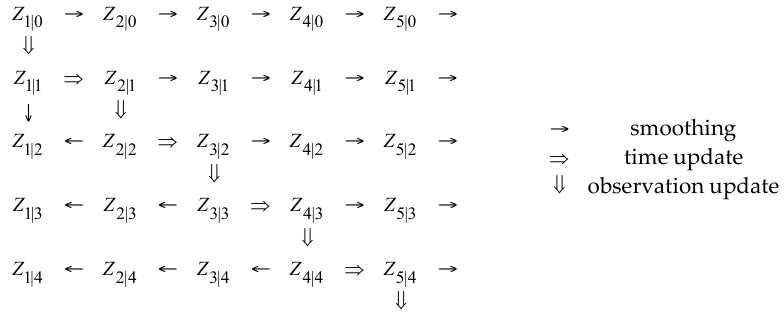
Figure 3. Schematic overview of the KF scheme (adapted from [32]).